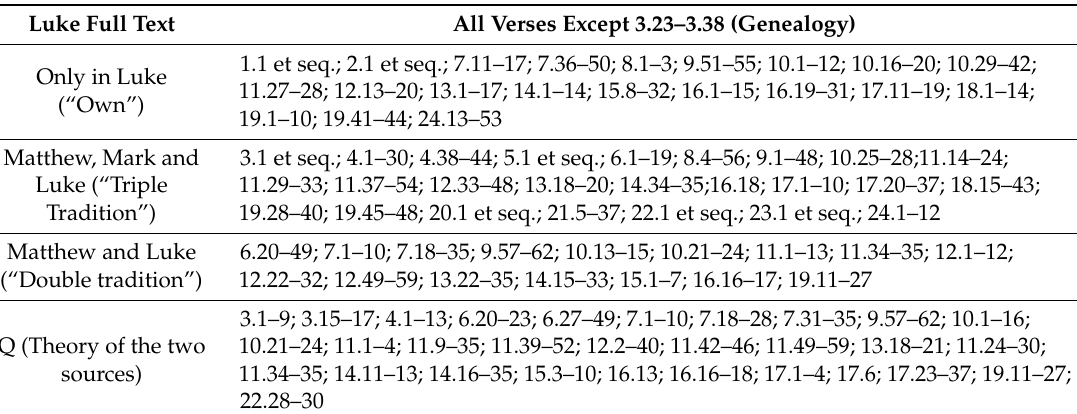
Table 1. List of the verses considered in Luke, in the indicated texts. The list of names (genealogy) in Verses 3.23–3.38 has not been considered in the statistical